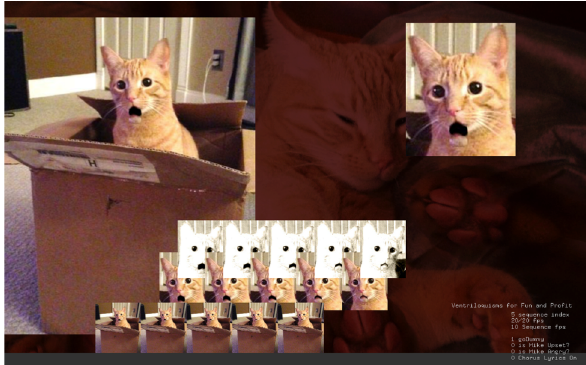
Figure 10 | Ventriloquisms for Fun and Profit screenshot (2013). Audio asset: http://blurringartandlife.com/vb/ventriloquisms.html.